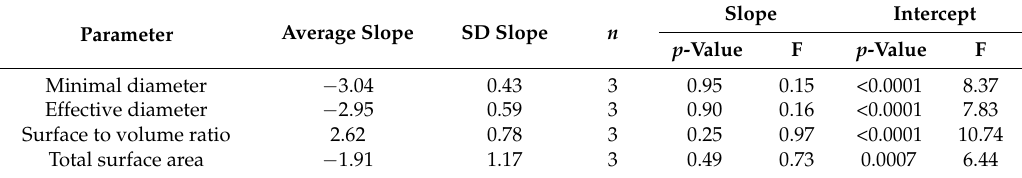
Table 3. Calculated average slope and corresponding standard deviation (SD) for effective diameter, surface to volume ratio, minimal diameter, and total surface area. For each parameter, the difference of the individual slopes of the metallic NPs is depicted by means of the p -value and the corresponding F-value in combination with the number of slopes (n), as well as the difference of the intercept (elevation) of the regression lines. For regression lines that are based on a maximum of five data points (see Figure 3), the significance level was set at p <